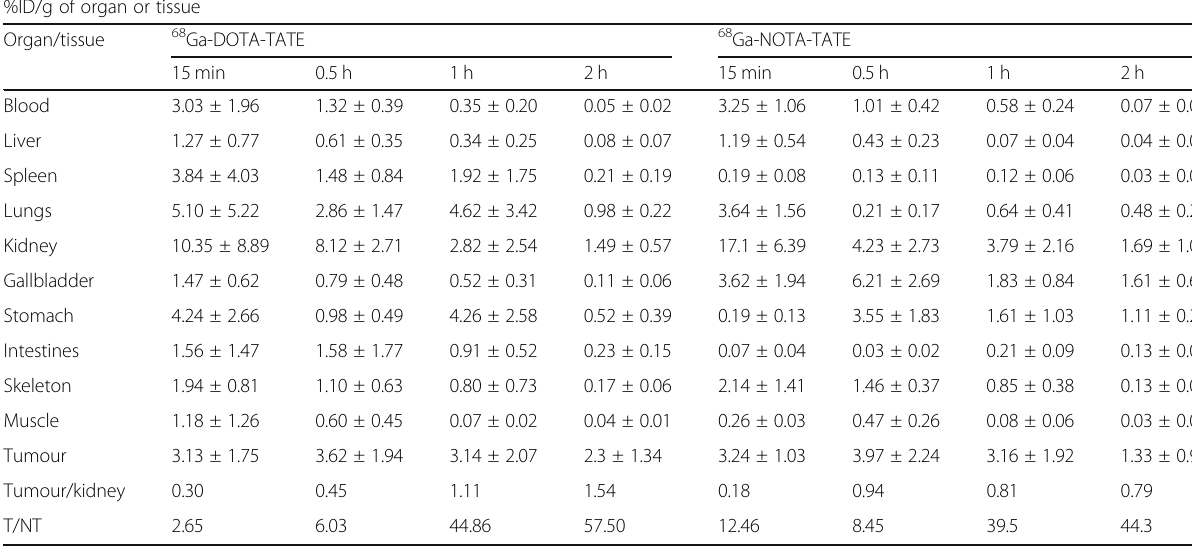
Table 1 Biodistribution of 68 Ga-NOTA-TATE and 68 Ga-DOTA-TATE in percentage of injected dose per gramme of organ at 15 min, 0.5 h, 1 h and 2 h postinjection in mice bearing AR42J tumours %ID/g of organ or tissue